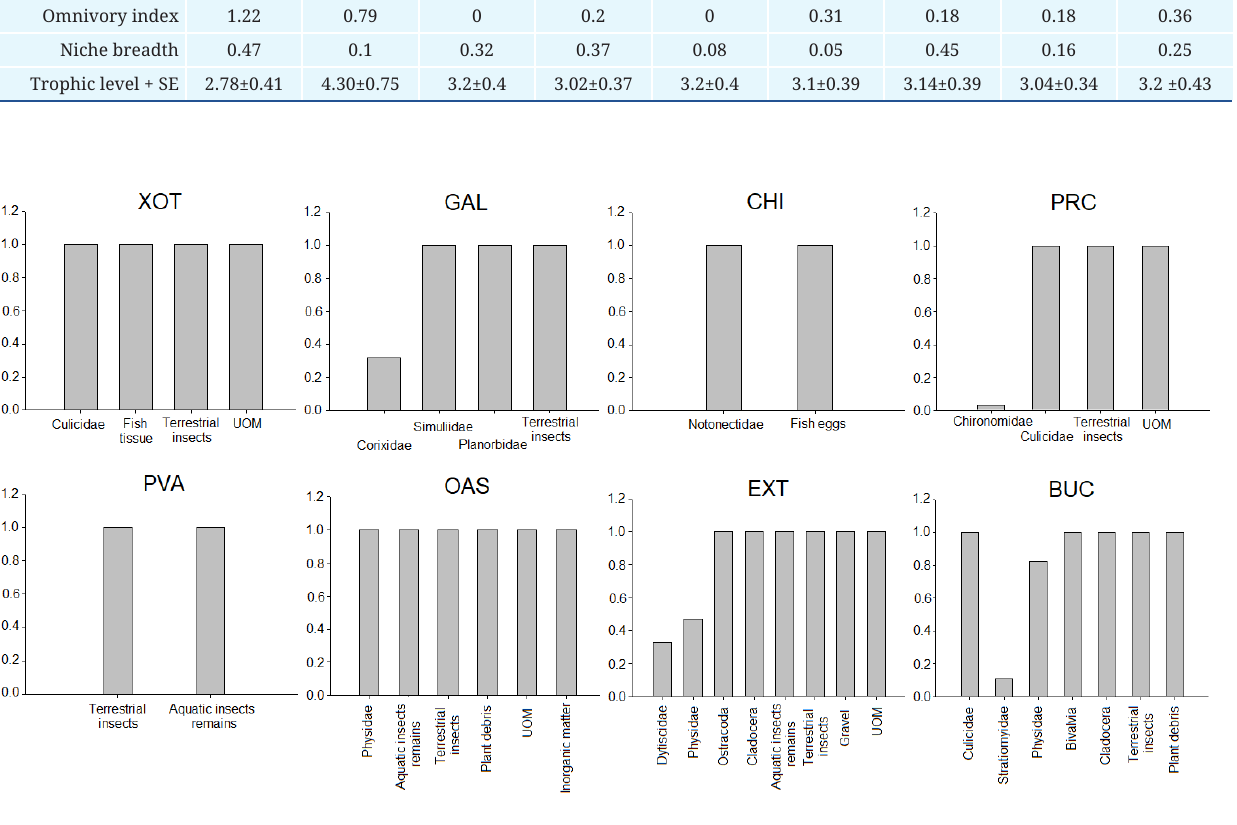
FIGURE 3 | Ivlev's Electivity index values for the food items of the diet of Pseudoxiphophorus bimaculatus in central Mexico. X axis=Prey electivity and Y axis=Prey taxa. XOT = El Xote; GAL = Los Galvanes; CHI = El Charco del Ingenio; PRC = Presa del Carmen; PVA = Paso de Vaqueros; OAS = Oasis; EXT = Extoraz; BUC =